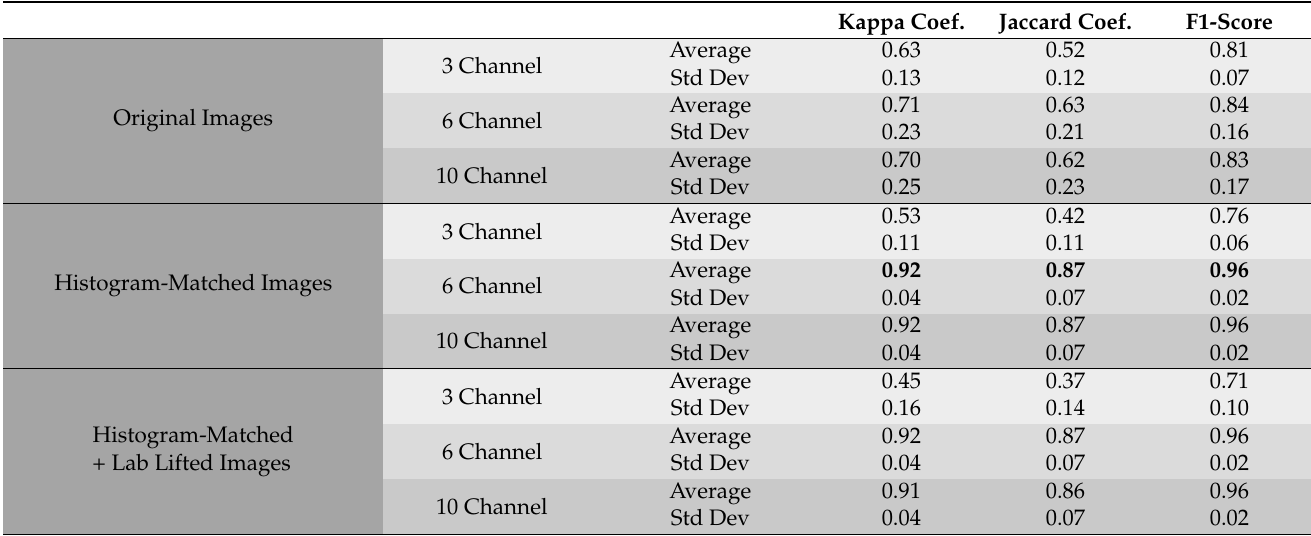
Table A6. Binary Change detection results for the E-ReCNN method. Different channels results represented with background and the highest result with the minimum channel was 6 Channel results shown with bold text.